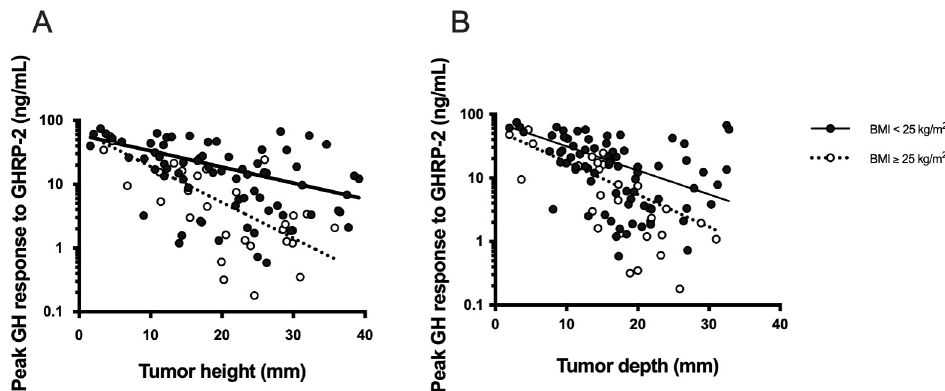
Fig 3. Peak GH response to GHRP-2 and tumor size in overweight and non-overweight patients. (A, B) Open circles and closed circles represent peak GH response to GHRP-2 in overweight (BMI � 25 kg/m 2 ) and non- overweight patients (BMI < 25 kg/m 2 ), respectively. The dotted and solid lines represent linear regression curves between peak GH response to GHRP-2 and tumor height (A) and tumor depth (B) in overweight (BMI � 25 kg/m 2 ) and non-overweight patients (BMI < 25 kg/m 2 ), respectively. GH, growth hormone; GHRP-2, growth hormone- releasing peptide-2; BMI, body mass index.